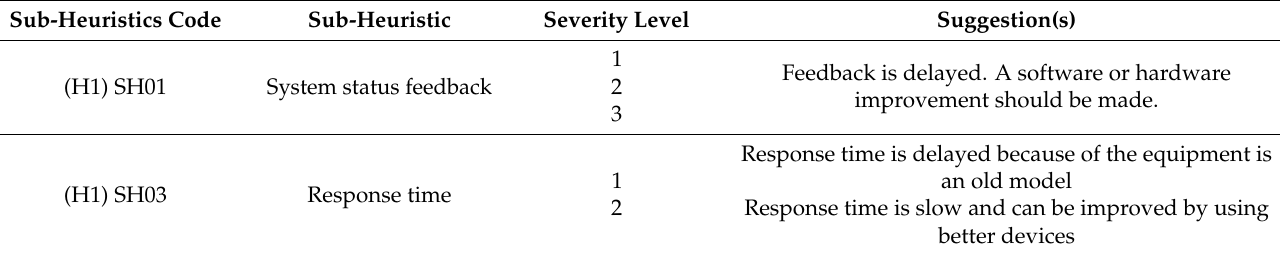
Table A5. UX Experts’ Suggestions for the VNMH’s Audio